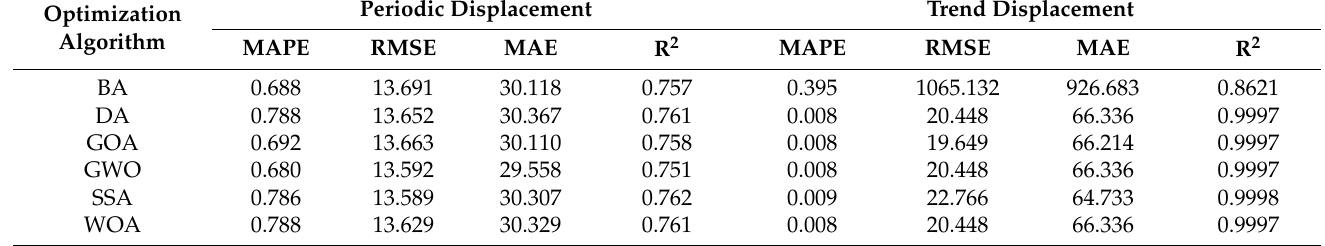
Table 5. Prediction accuracy of each SI in Baishuihe landslide.